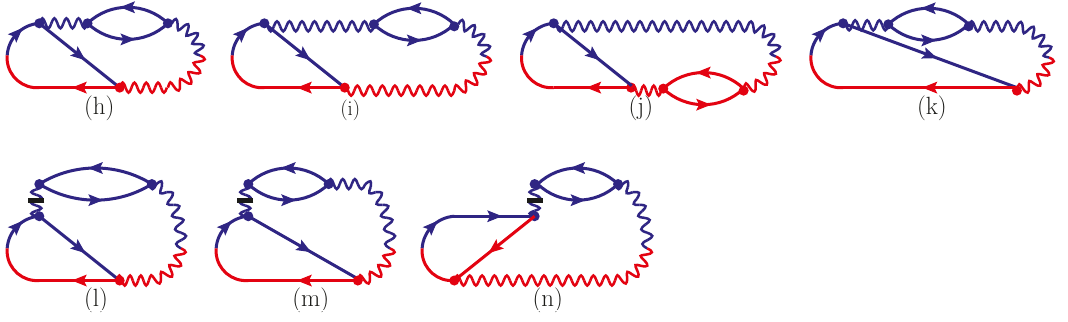
Figure 15 . Time-ordered interference diagrams for the virtual correction to e ! (cid:13)e in large- N f QED [16]. Again, complex conjugates should be included by taking 2 Re[ (cid:1) (cid:1) (cid:1)